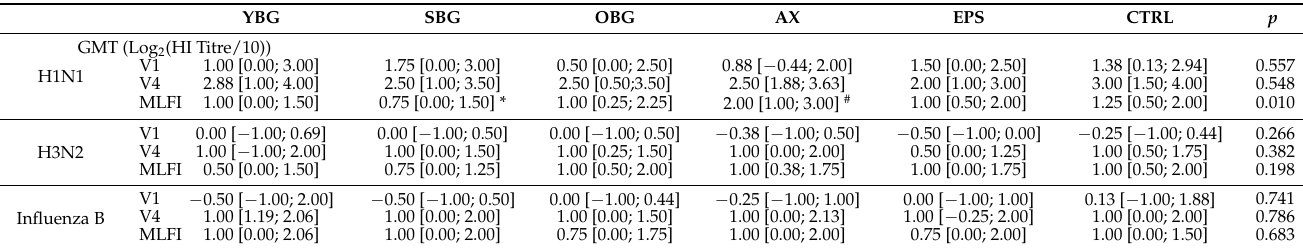
Table 2. Haemagglutination inhibition (HI) titres at baseline (V1) and three weeks after vaccination (V4) in the different NPS intervention groups.